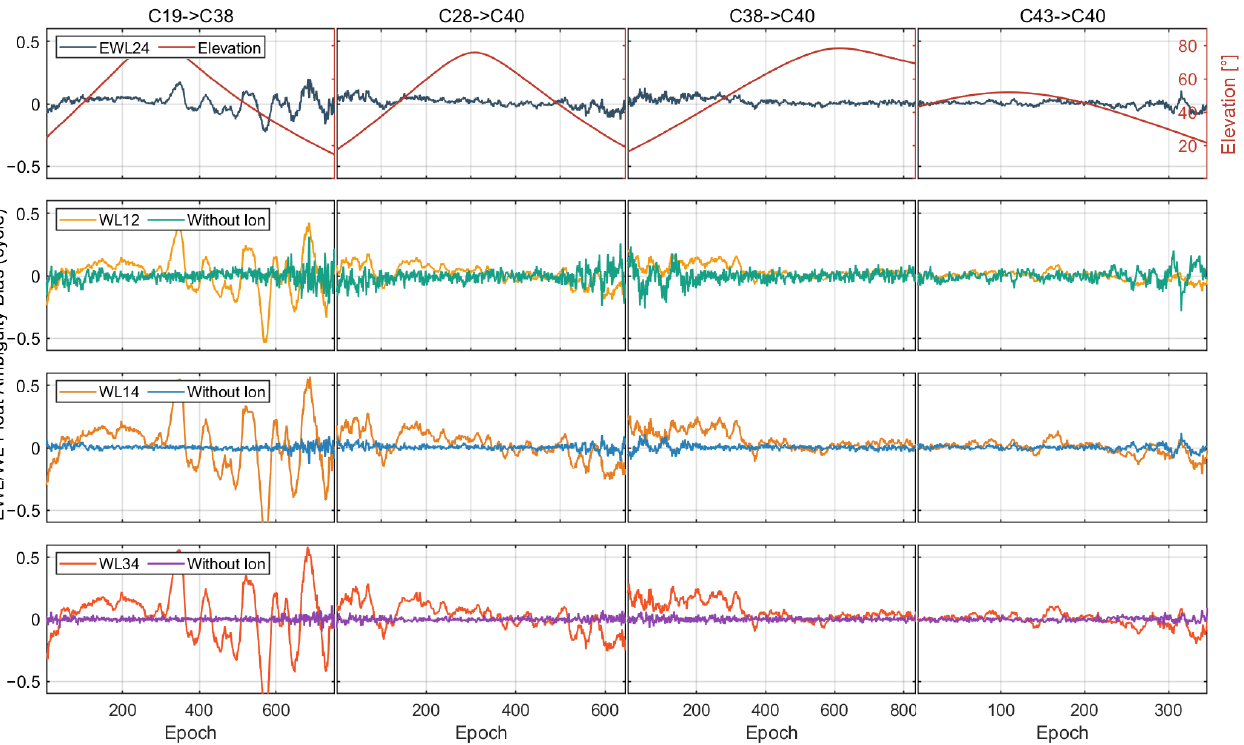
Figure 4. Float ambiguity bias of EWL (extra-wide-lane)/WL (wide-lane). The floating solution biases of WL ambiguities were counted, and are displayed as histograms in Figure 5. The upper panel shows the result after ionospheric correction, and the lower panel shows the result without ionospheric correction. It can be seen from the figure that the WL floating solution bias after ionospheric correction was more concen- trated around 0 cycle, and most deviations are less than 0.1 cycles, especially for combi- nations WL 14 and WL 34 .